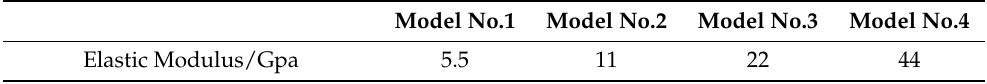
Table 9. Different elastic modulus value models.